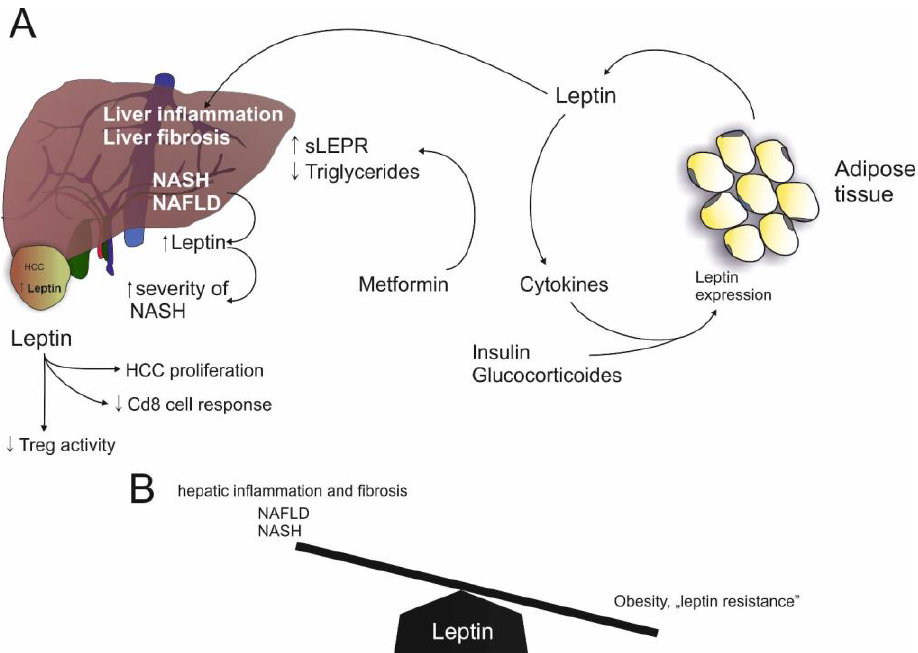
Figure 2. Leptin in NAFLD: ( A ) Leptin expression is induced by insulin, glucocorticoids and cytokines and leptin stimulates cytokine expression. Furthermore, leptin induces hepatic inflammation and fibrosis. Likewise, NAFLD and NASH are associated with increased leptin levels. On the other hand, Metformin induces sLEPR (soluble leptin receptor). In HCC, leptin induces proliferation but reduces CD8 response and Treg (regulatory T cell) activity; ( B ) Increased levels of leptin are associated with hepatic inflammation and fibrosis, as seen in NAFLD and NASH. On the other hand, low leptin levels are associated with leptin resistance in obesity. Table 1. Adiponectin and Leptin in NAFLD and HCC.